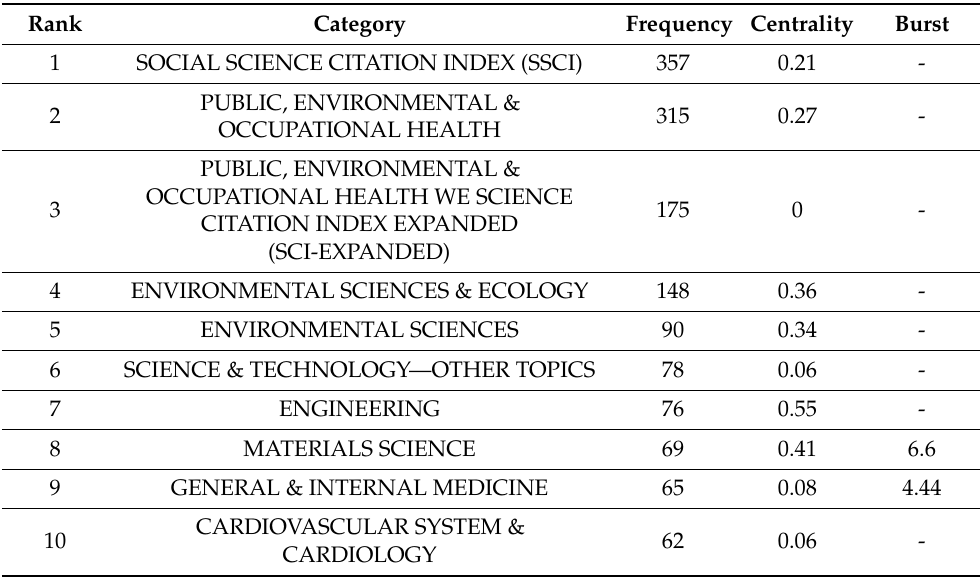
Table 5. The top 10 subject categories.